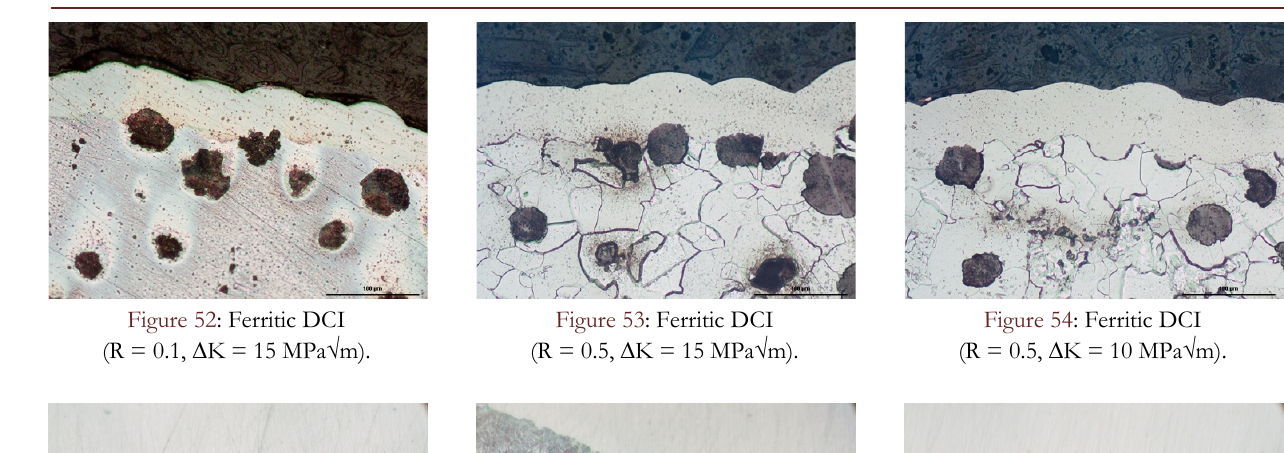
Figure 52: Ferritic DCI (R = 0.1,  K = 15 MPa √ m).